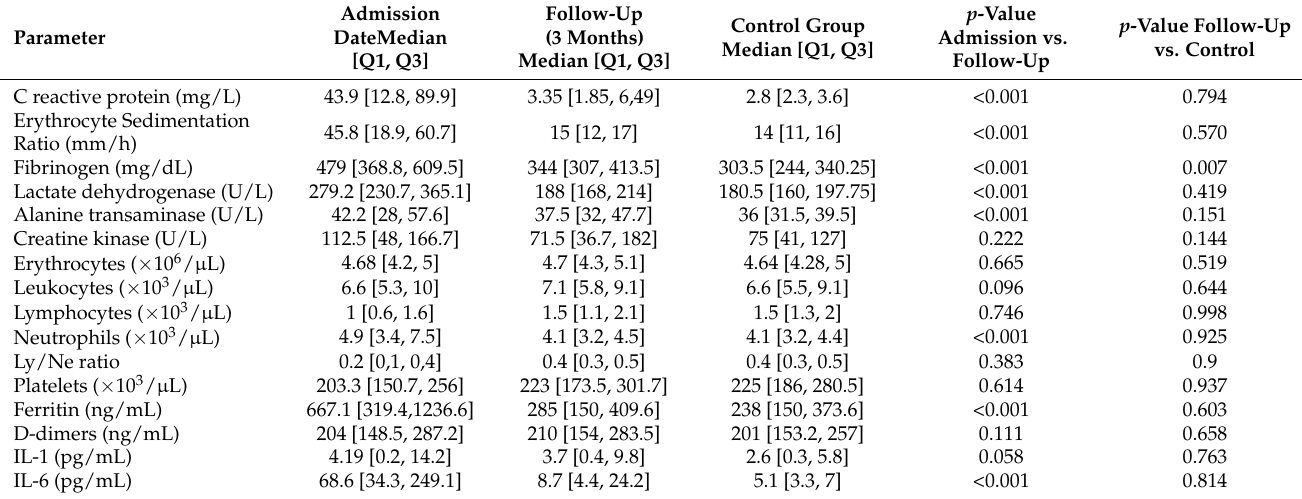
Table 1. Biologic parameters in study group and control group.